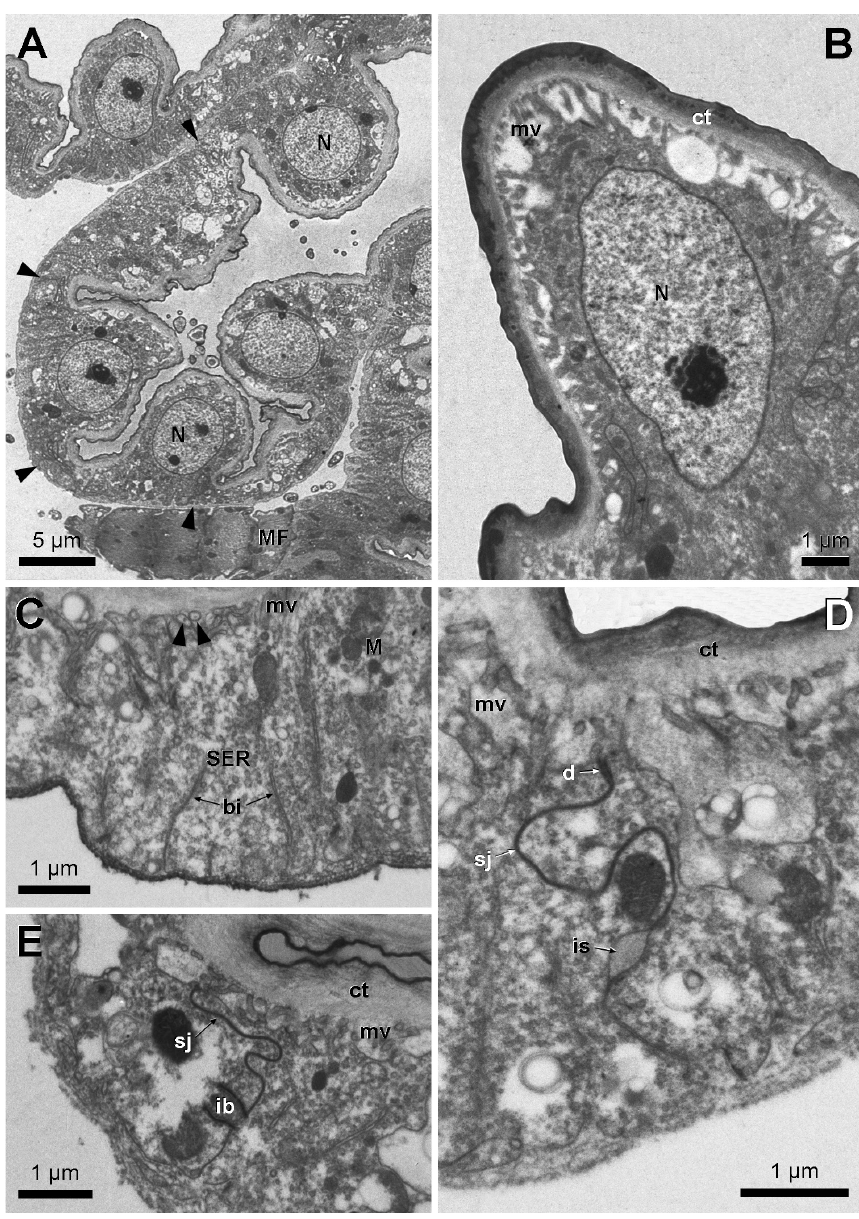
Figure 3. Electron micrographs of Dufour gland secretory cells in Myzinum sp.1. A Low magnification survey of crenellate epithelium, arrowheads indicate cell junctions B Cupola-like apical part of gland cell with nucleus (N) C Low lateral part of gland cell with apical microvilli (mv) and basal invaginations (bi). Arrowheads indicate extensions of smooth endoplasmic reticulum (SER) into microvilli D Detail of in- tercellular junction with apical desmosome (d), followed by septate junction (sj). Note intercellular space (is) wedged in between neighbouring cell walls. E . Occurrence of intercellular bridge (ib). ct: cuticle, M: